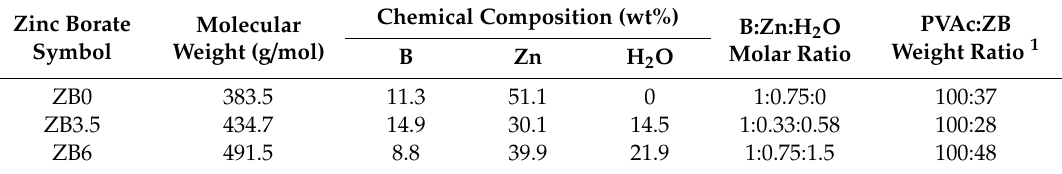
Table 3. Characteristics of the zinc borates.